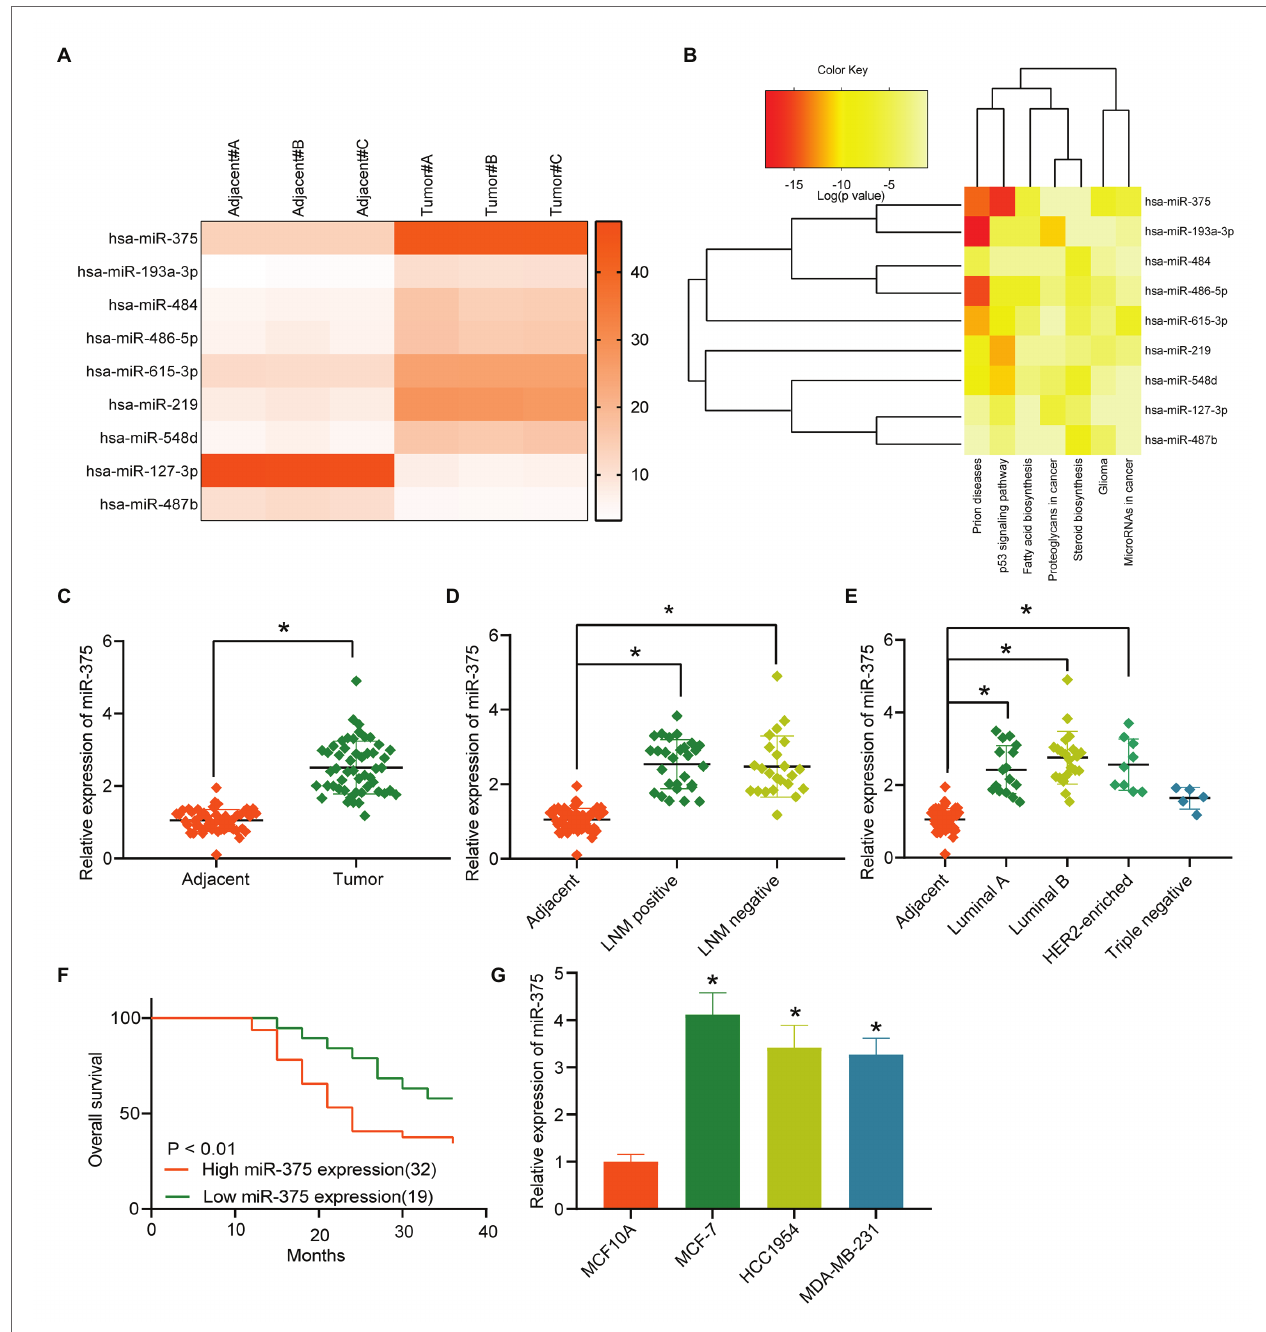
FIGURE 1 | miR-375 is a possible prognostic biomarker of BC. (A) Differentially expressed miRNAs between cancer and normal tissues from BC patients screened out by a miRNA microarray analysis; (B) gene and pathway cluster analysis based on the target genes of the differentially expressed miRNAs; (C) miR-375 expression in cancer and normal tissues determined by RT-qPCR (* p < 0.05, paired t test); (D) miR-375 expression in LNM-positive cancer tissues and LNM-normal ones determined by RT-qPCR (* p < 0.05, one-way ANOVA); (E) miR-375 expression in different BC subtypes examined by RT-qPCR (* p < 0.05, one-way ANOVA); (F) survival rate of patients according to the follow-up study; (G) miR-375 expression in BC cells (MCF-7, HCC1954, and MDA-MB-231) and in normal MCF10A cells detected by RT-qPCR (* p < 0.05, one-way ANOVA). Data were presented as mean ± SD from three independent